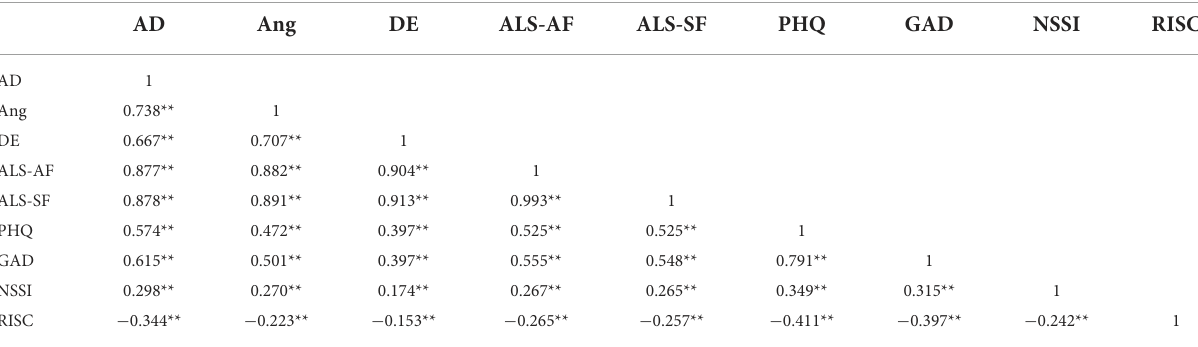
TABLE 6 Correlation between affective lability and depression, anxiety, self-harm and resilience ( n = 1,439). AD Ang DE ALS-AF RISC